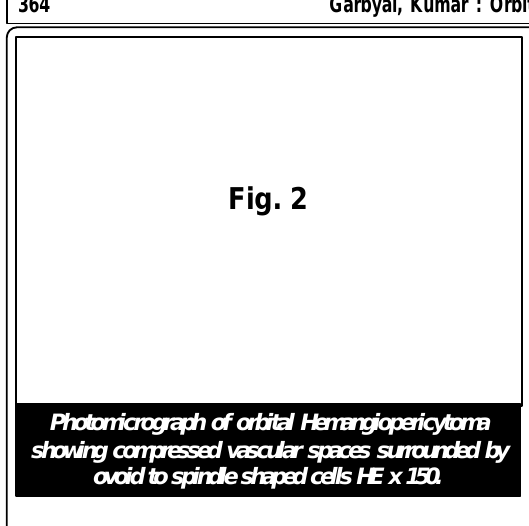
Photomicrograph of orbital Hemangiopericytoma showing compressed vascular spaces surrounded by ovoid to spindle shaped cells HE x